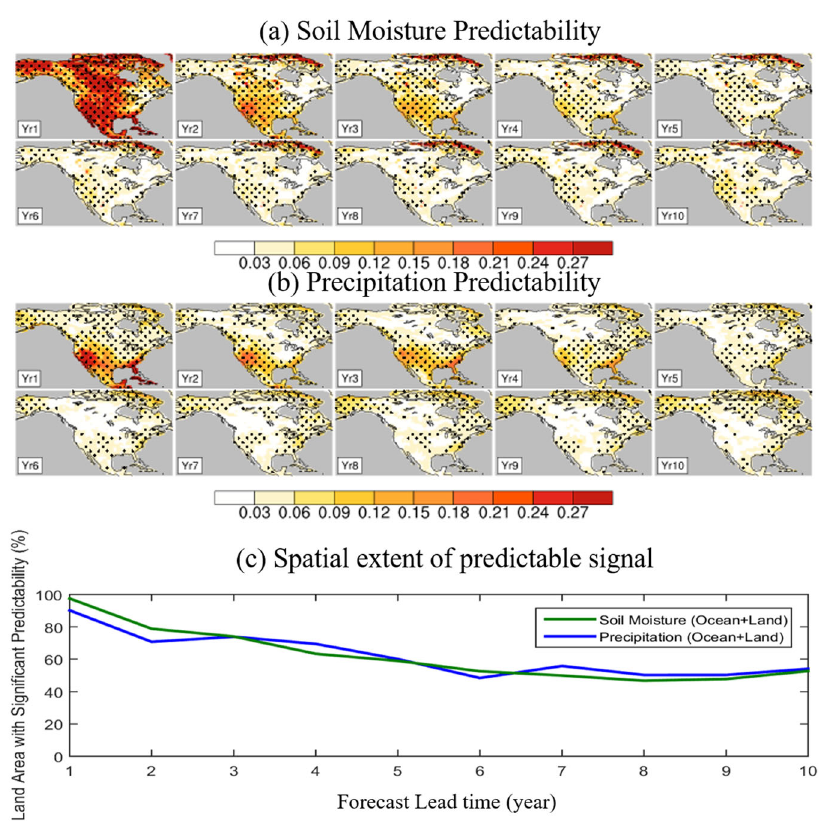
Fig. 4 The annual average predictability of (a) the root zone (0 – 0.5 m) soil moisture and its comparison with (b) the precipitation predictability in the CESM-DPLE, and using signal to (signal + noise) ratio metric. Twelve-month average anomalies (non-overlapping) are calculated for each year of the forecast lead time, and before calculating the signal to total ratio. Stippling shows statistical signi fi cance at a 95% con fi dence level. The bottom panel ( c ) shows areas of the signi fi cant predictability area for soil moisture and precipitation in North